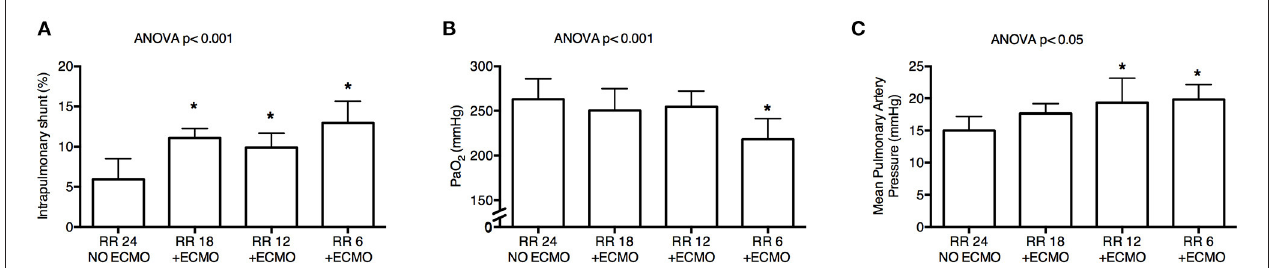
FIGURE 3 | Physiological effects of lower respiratory rate and higher extracorporeal CO 2 removal by ECMO. Progressive decrease of respiratory rate induced significant increase of intrapulmonary shunt calculated with Riley’s method (A) , poorer systemic oxygenation (B) , and higher mean pulmonary artery pressure (C) . RR, respiratory rate; ECMO, extracorporeal membrane oxygenation; PaO 2 , arterial partial pressure of oxygen. * p < 0.05 Post-Hoc Holm–Sidak method vs. Baseline.